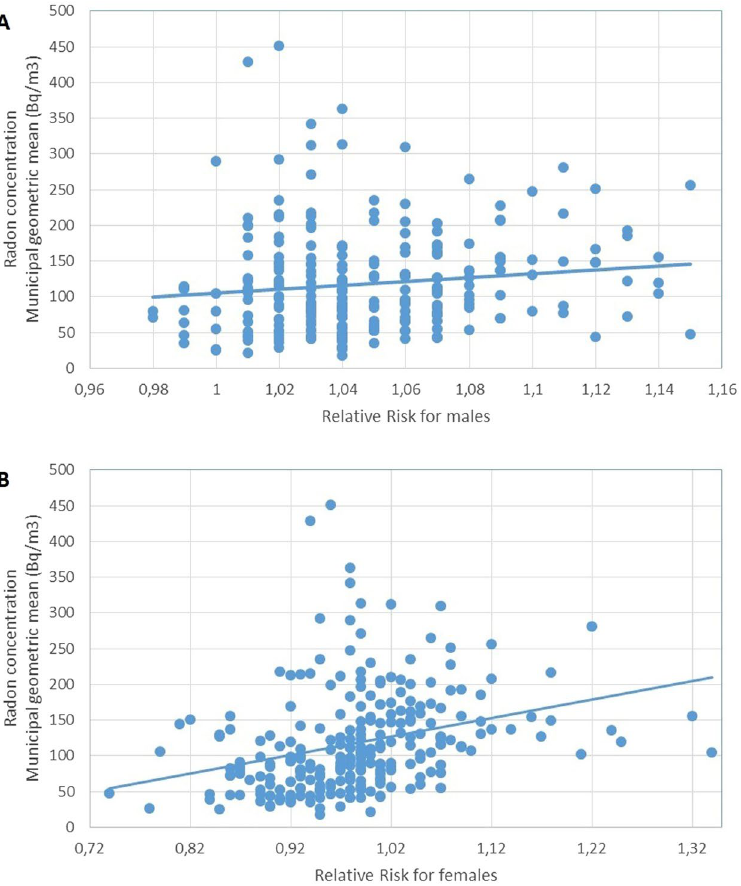
Figure 1. Scatterplot showing the correlation between municipal radon concentration and relative risk of mortality for brain cancer in ( A ) males, and ( B )